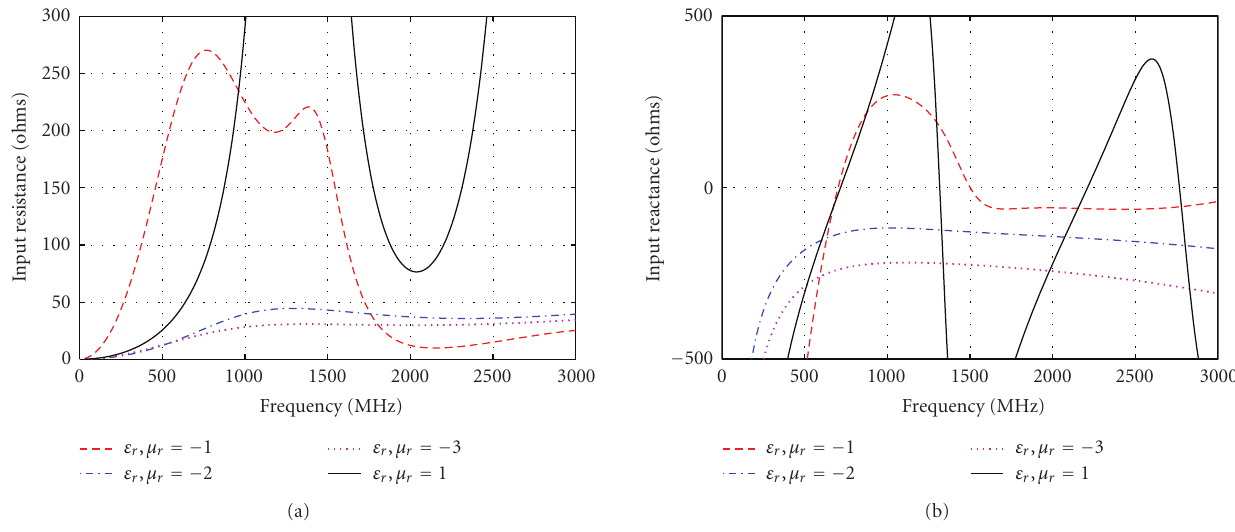
Figure 6: (a) Input resistance, and (b) reactance. Other parameters: L = 200 mm, a = 0 . 3175 mm, b = 1 . 8542 mm, r = 0 . 3175 mm, and N =